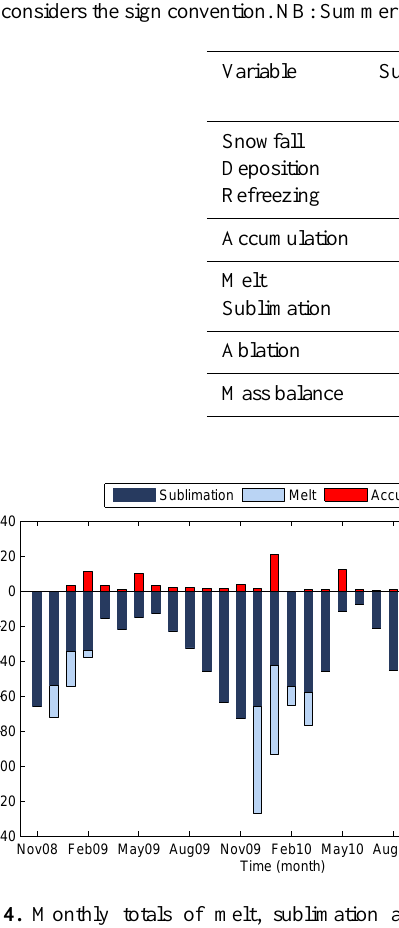
Table 3. Sum of mass fluxes per season per year (mmw.e.). All single terms are shown as absolute values, but the mass balance result (last